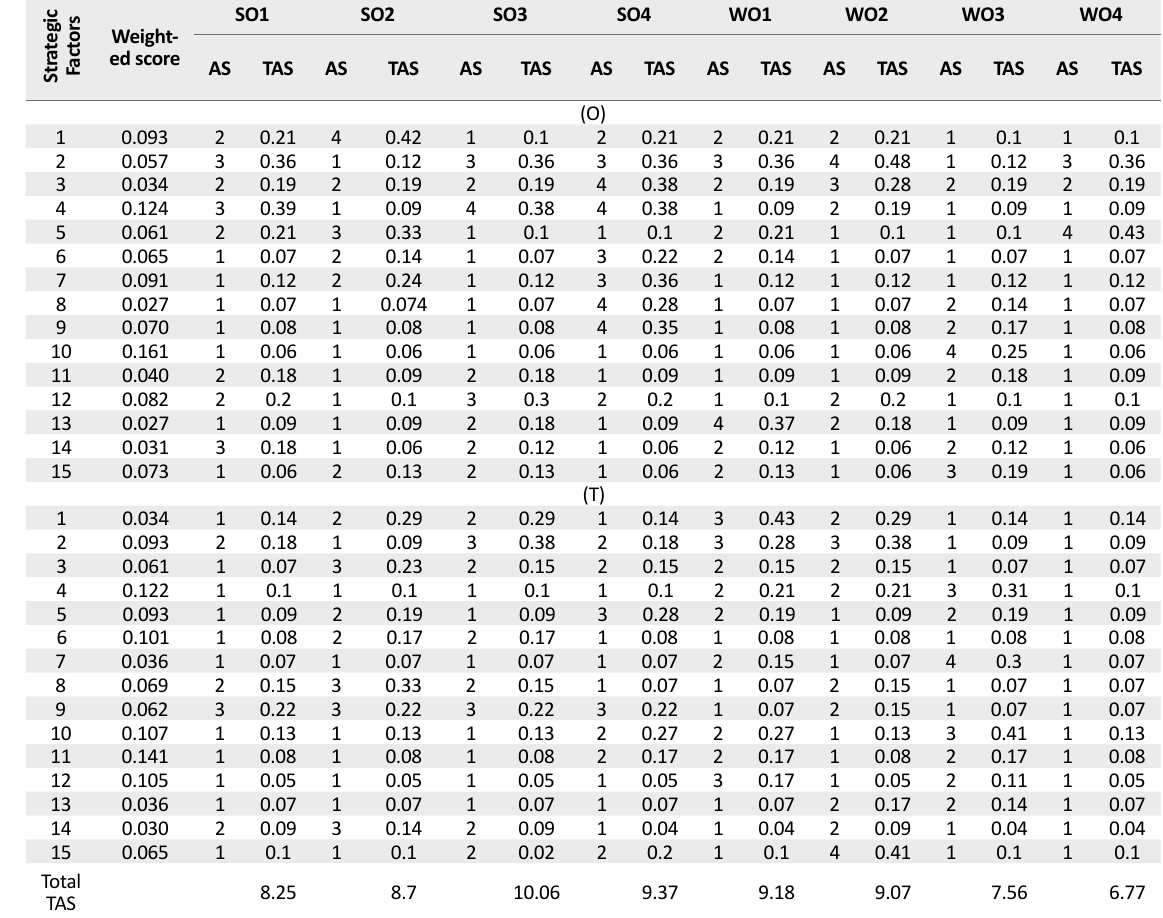
Table 4. QSPM matrix for the evaluation of strategic